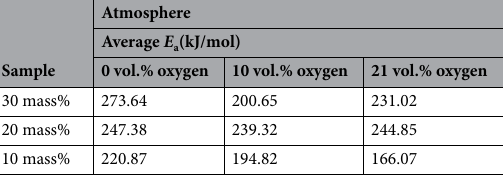
Table 4. The average E a calculation of NC-S in different atmosphere conditions via TG